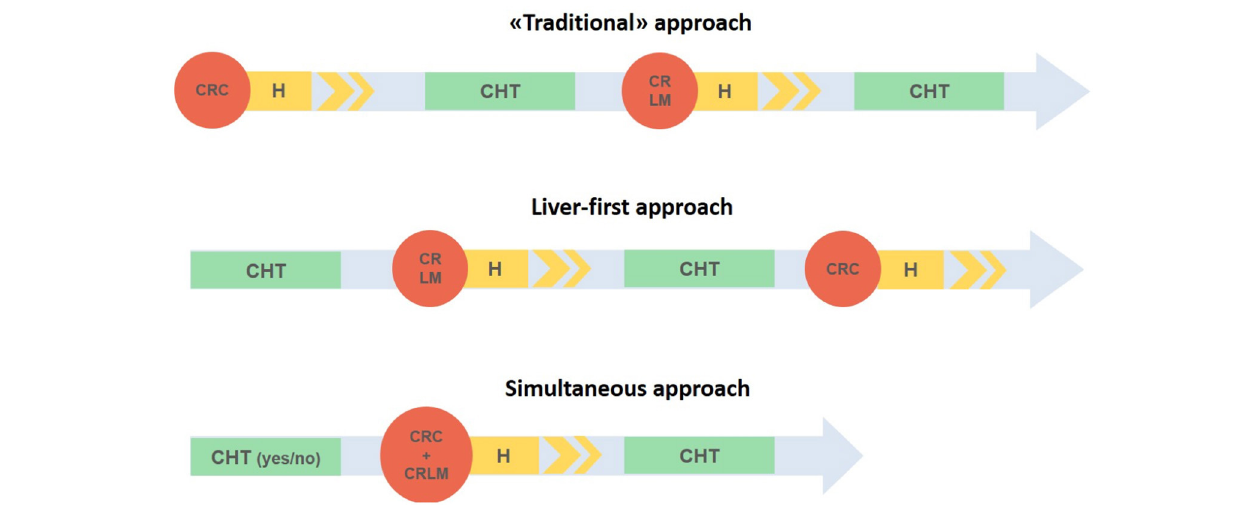
FIGURE 1 | Three different strategies in case of synchronous liver metastases and colorectal cancer. CRC, Colorectal cancer; CRLM, colorectal liver metastases; H, hospital stay; CHT, chemotherapy.